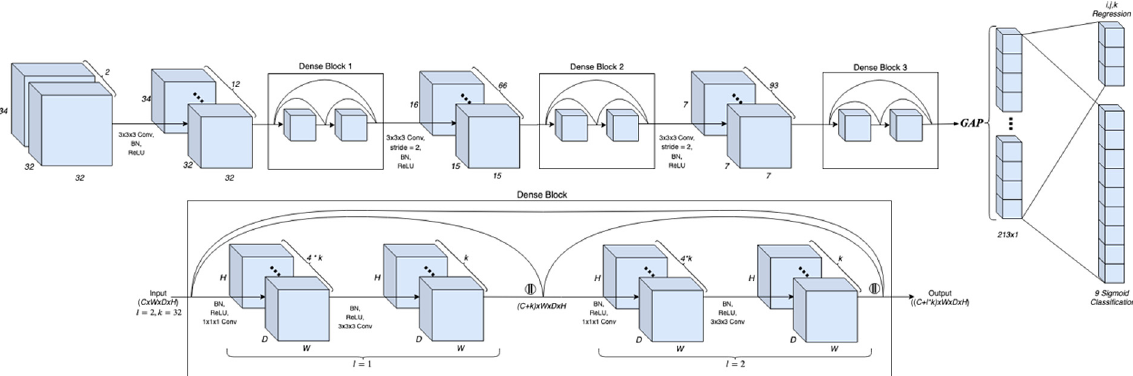
Fig. 3. The proposed Densely-connected 3D CNN architecture, depicting an example dense block of 2 layers and growth rate of 32. The Fully-connected and output layers can be seen right of the GAP, each unit represents a classi fi cation perturbation type or the source ( i, j, k ) location to